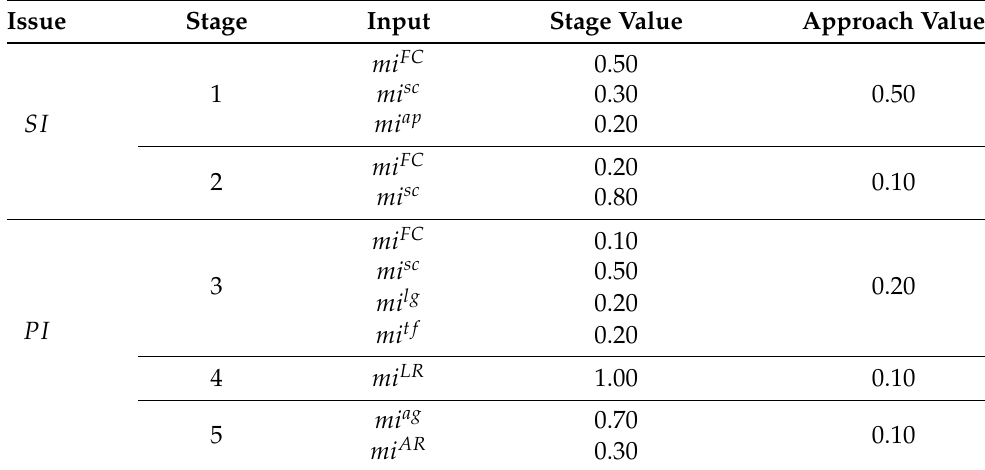
Table 2. Weighted values of the input data